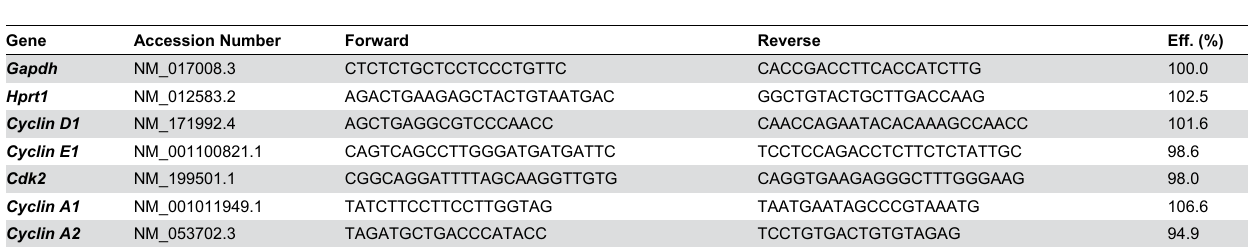
Table 1. Sequence of PCR primers for real-time PCR and efficiency.